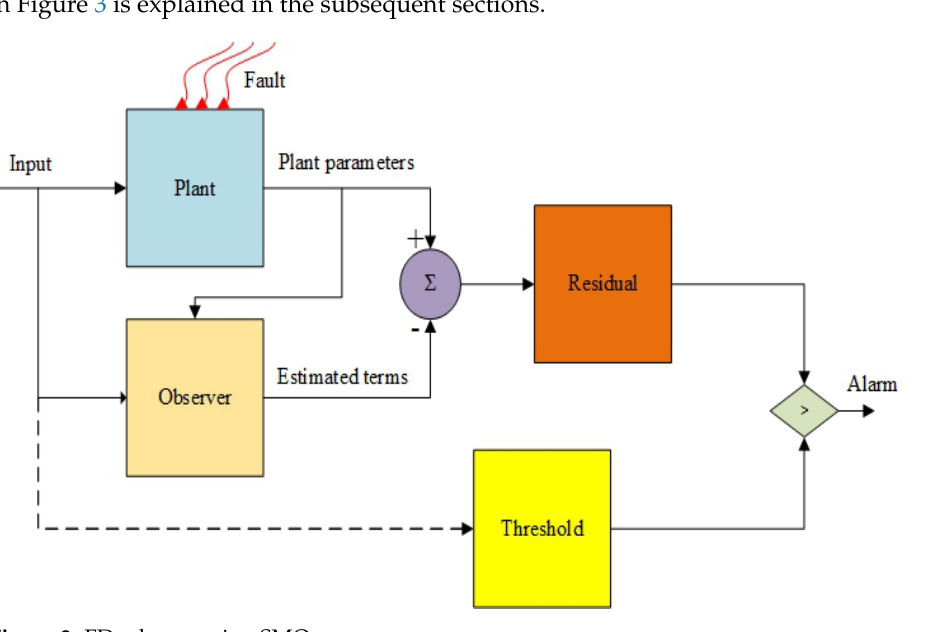
Figure 3. FD scheme using